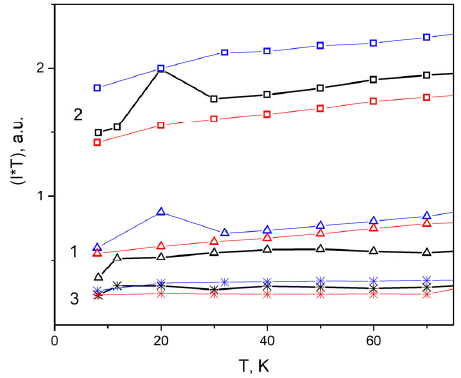
Figure 14. Temperature dependences of intensity of the separate resonance lines: line 1 (triangles), 2 (squares) and 3 (asterisk) for samples F-S-1, FA-S2-1-300, FA-S2-2-300 with different Al content: 0 at.% (black), 0.04 at.% (blue) and 0.81 at.% (red)) respectively. The intensity of the lines corresponding to the noninteracting moments of the iron ions (3) behaves in accordance with the Curie law, and the intensity of the lines with a g factor of 4.3 (1) also manifests itself in a similar way. The parameter (I·T) for the lines corresponding to the weakly interacting moments of iron (curves 2) shows some increase with temperature, which is typical for clusters [31]. To some extent, this behavior corre- lates with the behavior of the parameter ( χ ·T) (Figure 7b), which serves as additional con- firmation in favor of the realization of, not dimers, but of trimers or more complex iron clusters. However, strictly speaking, for a more reliable proof of this statement, it is nec- essary to measure both the susceptibility and the EPR spectra in the temperature range even closer to zero. The main conclusion that can be drawn from the analysis of the temperature depend- ence of the EPR spectra is that the local order of the nearest environment of iron ions (the presence of aluminum ions there or their absence) does not affect the change in individual components of the spectra with temperature.